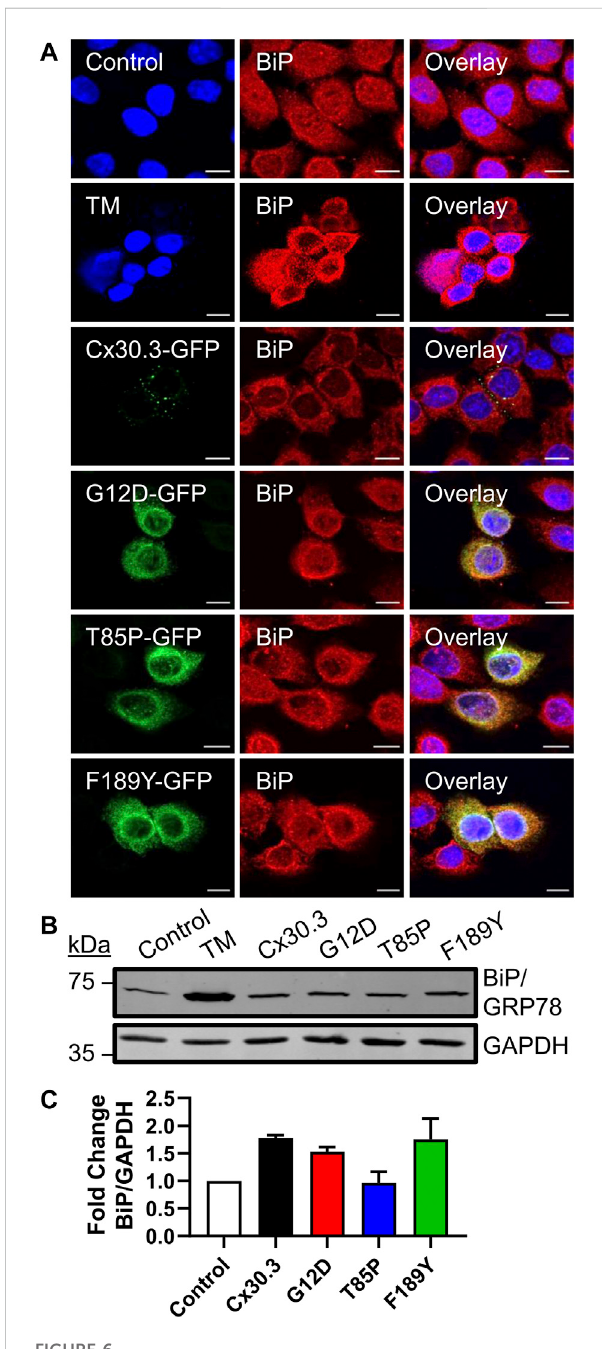
FIGURE 6 Cx30.3 mutants do not upregulate BiP/GRP78. (A) Representative confocal images of Cx43KO REKs expressing GFP- taggedwildtypeormutantCx30.3(green)labeledforBiP/GRP78(red). Cx43KO REKs treated with 2 μ g/mL tunicamycin (TM) to induce ER stress were used as a positive control for BiP/GRP78 upregulation. Untreated Cx43KO REKs served as a negative control. Nuclei counterstained with Hoechst 33342 (blue). Scale bars = 10 µm. (B) Representative immunoblot of BiP/GRP78 levels in Cx43KO REKs expressing wild type or Cx30.3 mutants, as well as negative and positive controls. GAPDH was used as a loading control. (C) Densitometry quanti fi cation reveals that the expression of either